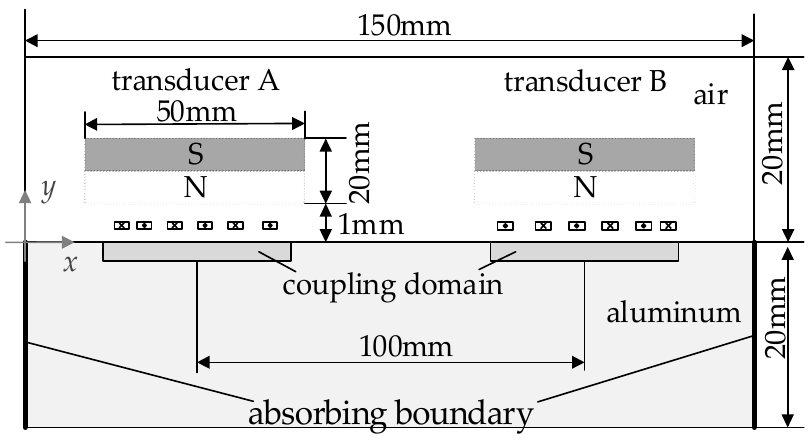
Figure 8. Geometry of the 2D FE model for RW-EMAT.